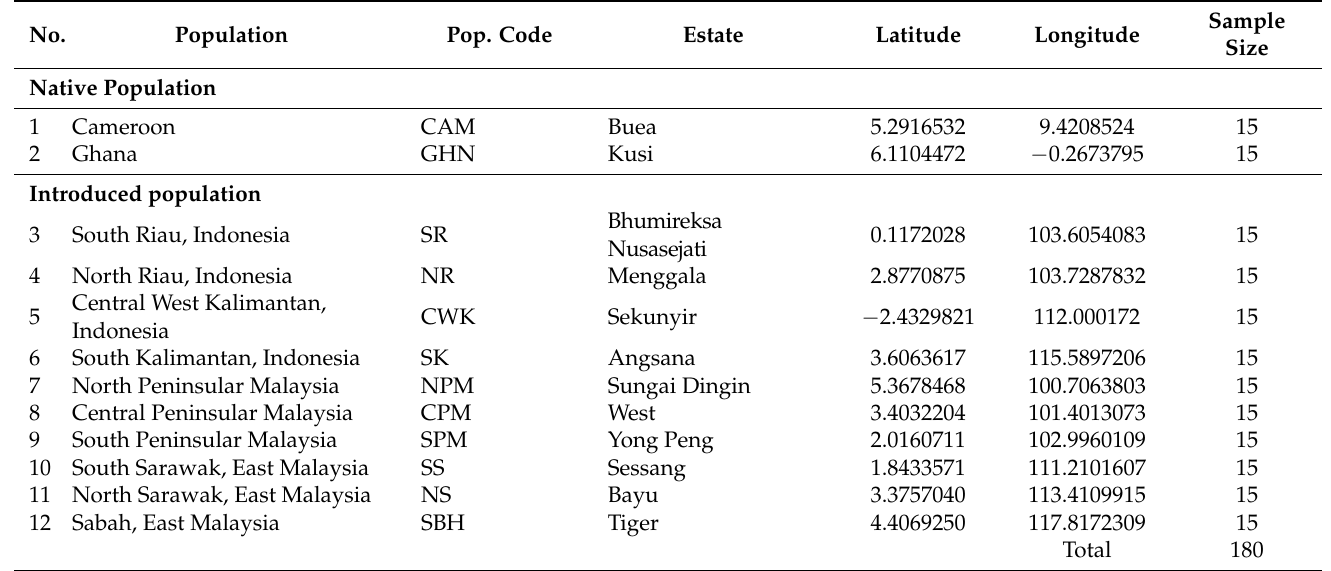
Table 1. Localities of 12 assayed E. kamerunicus populations in Malaysia, Indonesia, Ghana, and